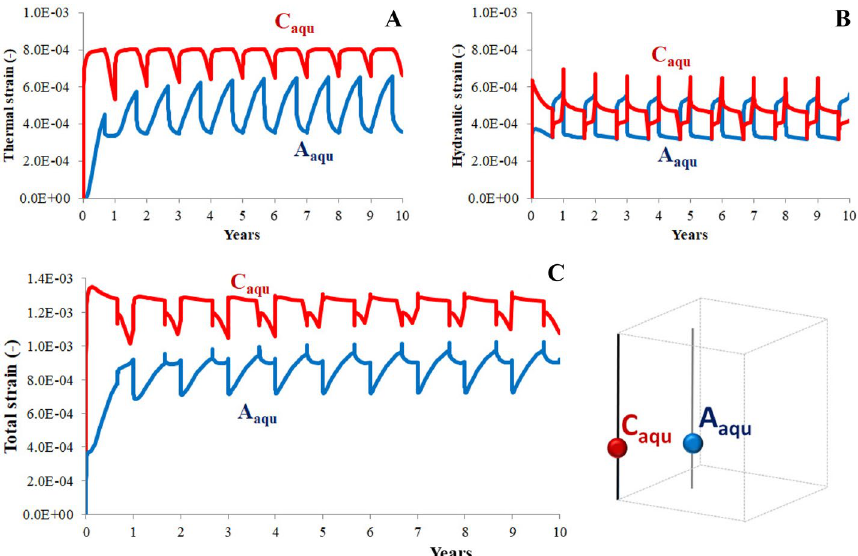
Fig. 13 Thermal strain ( A ), hydraulic strain ( B ) and total strain ( C ) in the central well (C aqu ) and in the auxiliary well